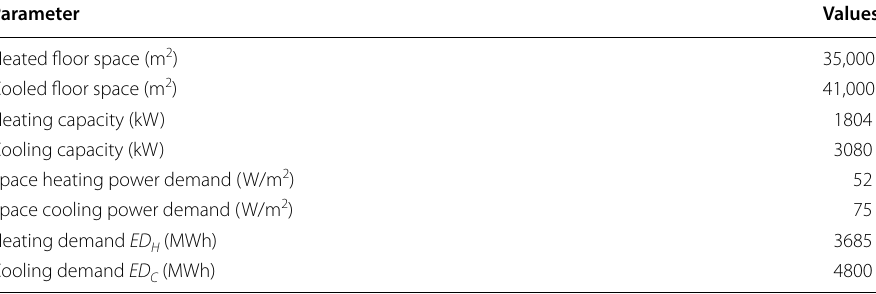
Table 2 Parameters defining the heating and cooling supply of the building Parameter Values Heated floor space (m 2 ) Cooled floor space (m 2 ) Heating capacity (kW) Cooling capacity